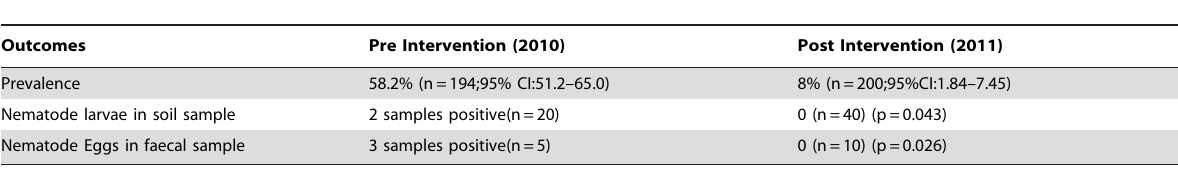
Table 2. Outcome variables before and after